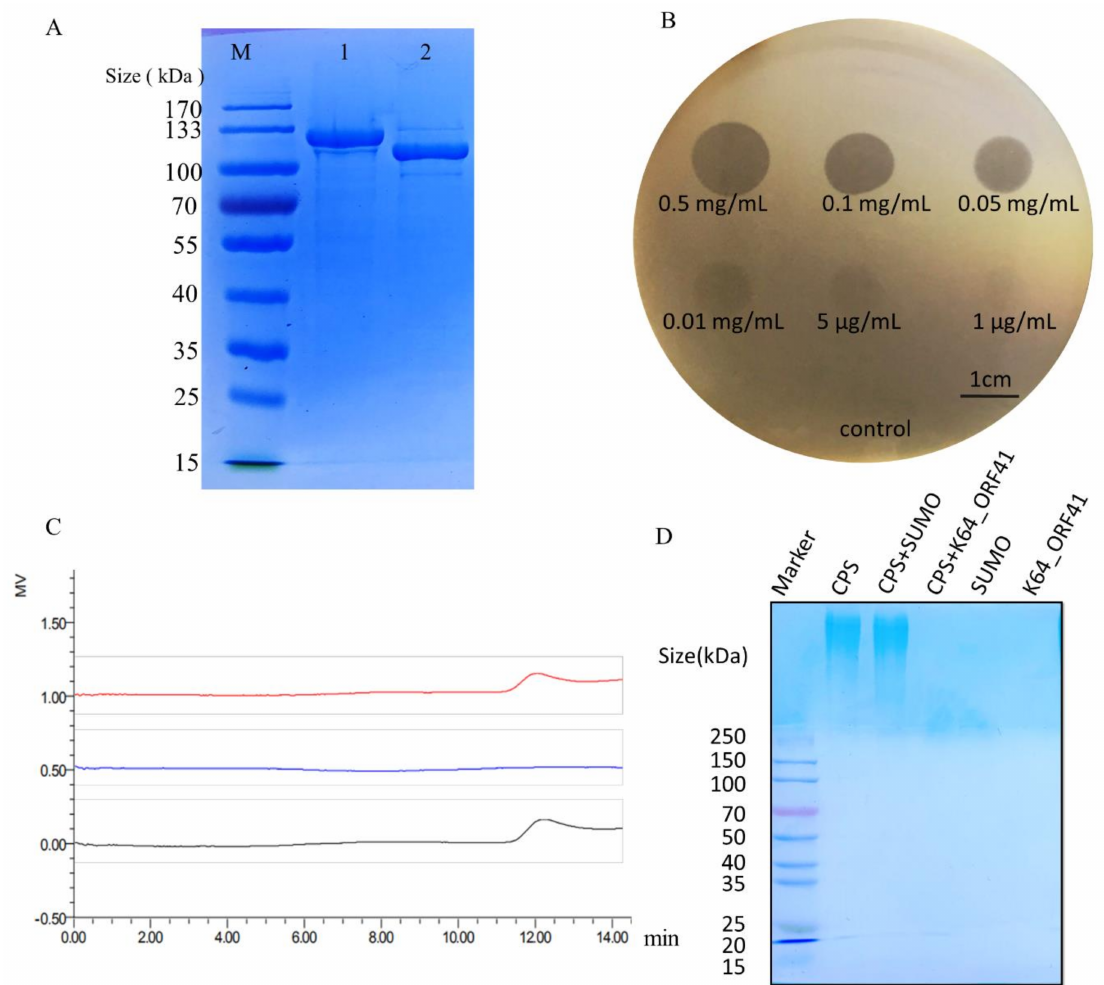
Figure 3. Expression, purification, and depolymerase activity evaluation of recombinant K64-ORF41. ( A ) The purified proteins were separated on 10% SDS-PAGE followed by Coomassie blue staining. Lane M, protein marker; lane 1, purified K64-ORF41-SUMO fusion protein; lane 2, K64-ORF41 without SUMO tag. ( B ) The enzymatic activity of K64-ORF41 was tested by the spot test using different concentrations on a lawn of K. pneumoniae strain 2410. SUMO protein was served as a negative control. ( C ) Size exclusion chromatography (SEC)-HPLC analysis of capsular polysaccharide (CPS) treated with K64-ORF41. Black line, purified untreated CPS; green line, CPS treated with 10 µ g/mL K64-ORF41 at 37 ◦ C for 30 min; red line, CPS incubated with 10 µ g/mL SUMO protein at 37 ◦ C for 30 min. ( D ) Alcian blue staining of CPS treated with the K64-ORF41. CPS was treated with or without K64-ORF41 and SUMO at 25 ◦ C for 30 min and stained with Alcian blue. In each panel, lane 1: marker; lane 2: purified untreated CPS; line 3: CPS treated with 10 µ g/mL SUMO; line 4: treated with 10 µ g/mL K64-ORF41; line 5: SUMO; line 6: